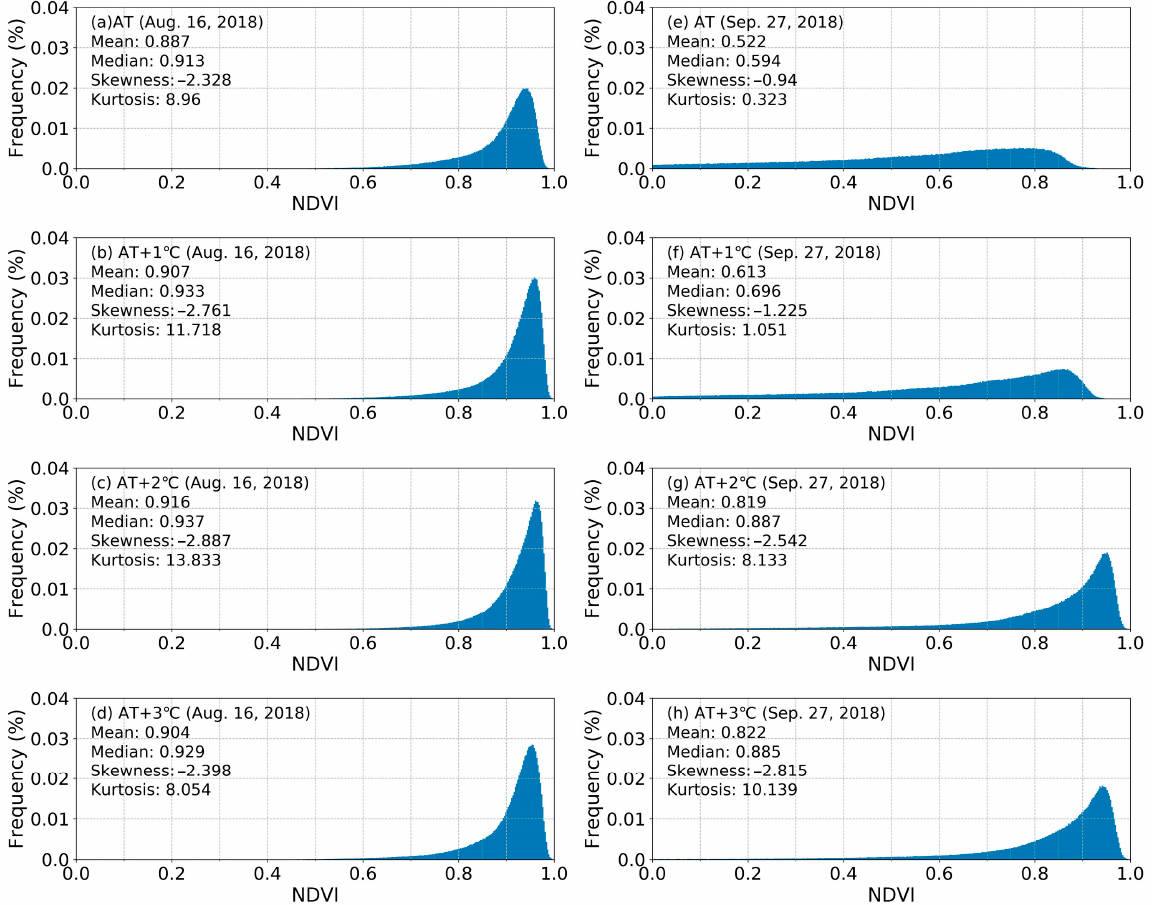
Figure 11. NDVI images for paddy rice measured by the multi ‐ spectral camera on 16 August 2018 (heading stage) ( a – d ) and 27 September 2018 (harvesting stage) under different air temperature con ‐ ditions ( e – h ). Color is observed when NDVI is above 0.5.